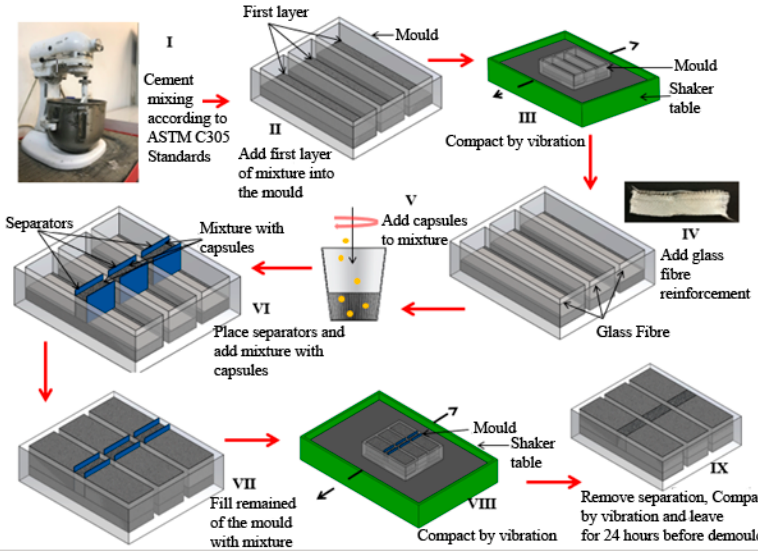
Figure 3. Preparation procedure for the cement paste and mortars containing CaAlg capsules.